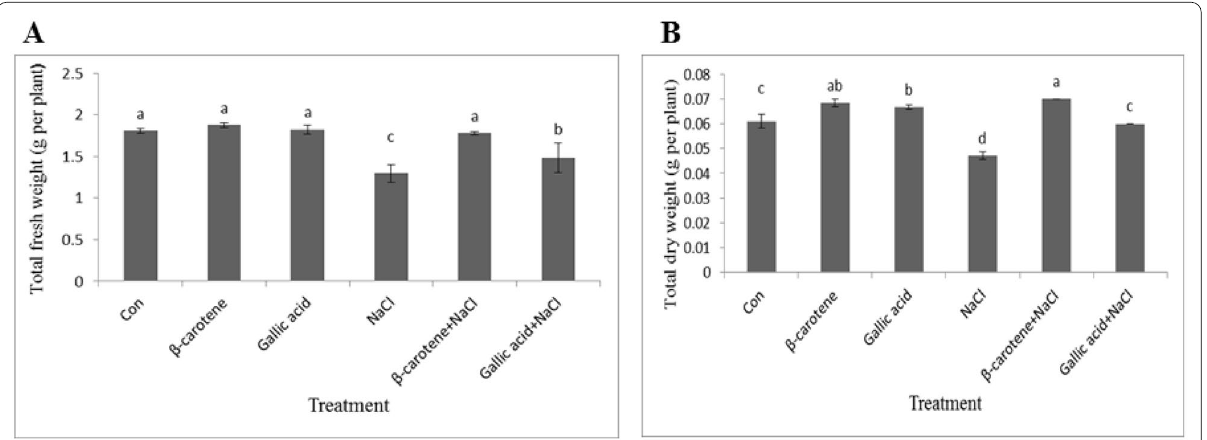
Fig. 2 Effect of β‑carotene and gallic acid, under saline and non‑saline conditions on the total fresh/dry weight in Lepidium sativum seedlings. Columns with the same letters are not statistically different at 5% probability using Duncan’s test